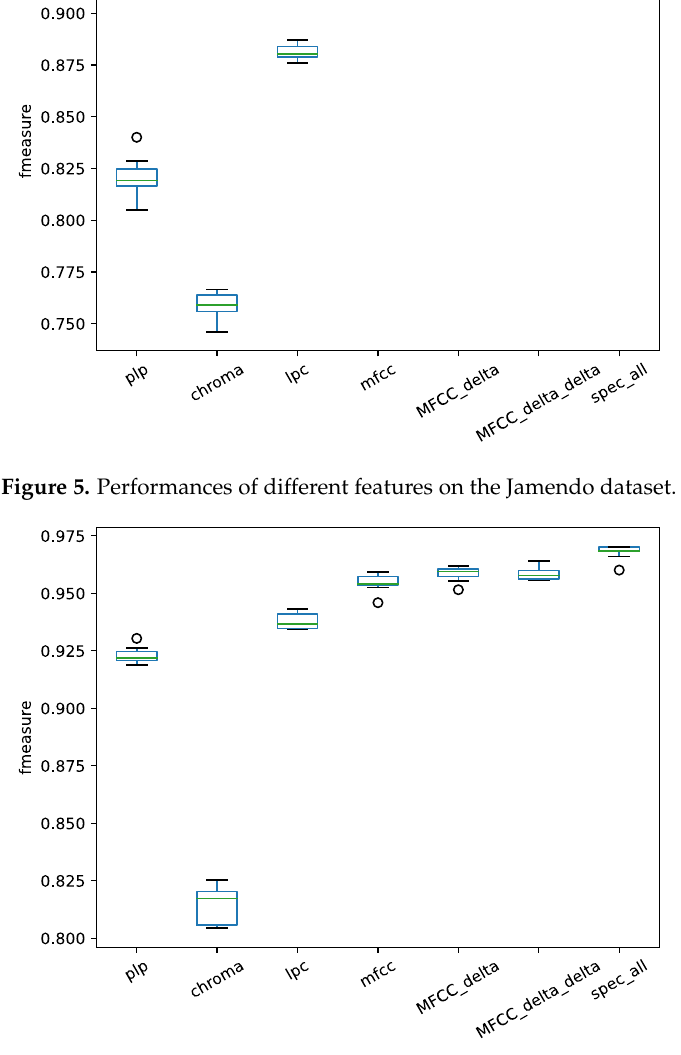
Figure 6. Performances of different features on the RWC